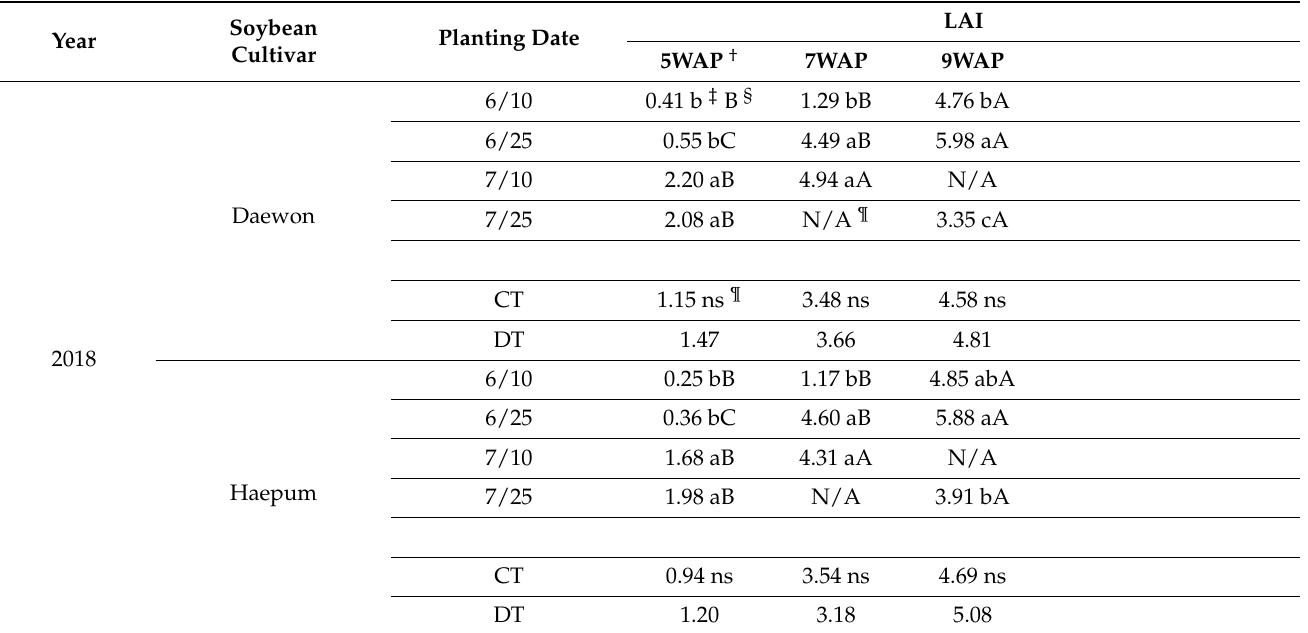
Table 7. LAI of two soybean cultivars (Daewon and Haepum), as affected by the planting date (6/10, 6/25, 7/10, and 7/25 in 2018; 6/15, 6/30, and 7/15 in 2019–2021) and tillage practice (deep tillage, DT; conventional tillage,